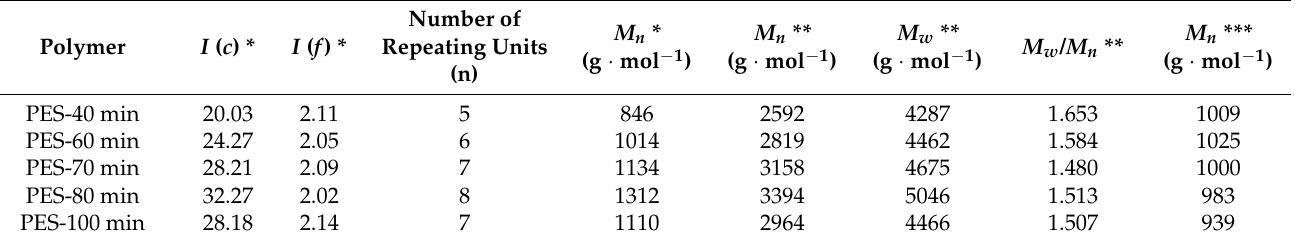
Table 1. Degree of polymerization, M n and M w values obtained from different methods and polydispersity index for the synthesized PES samples.